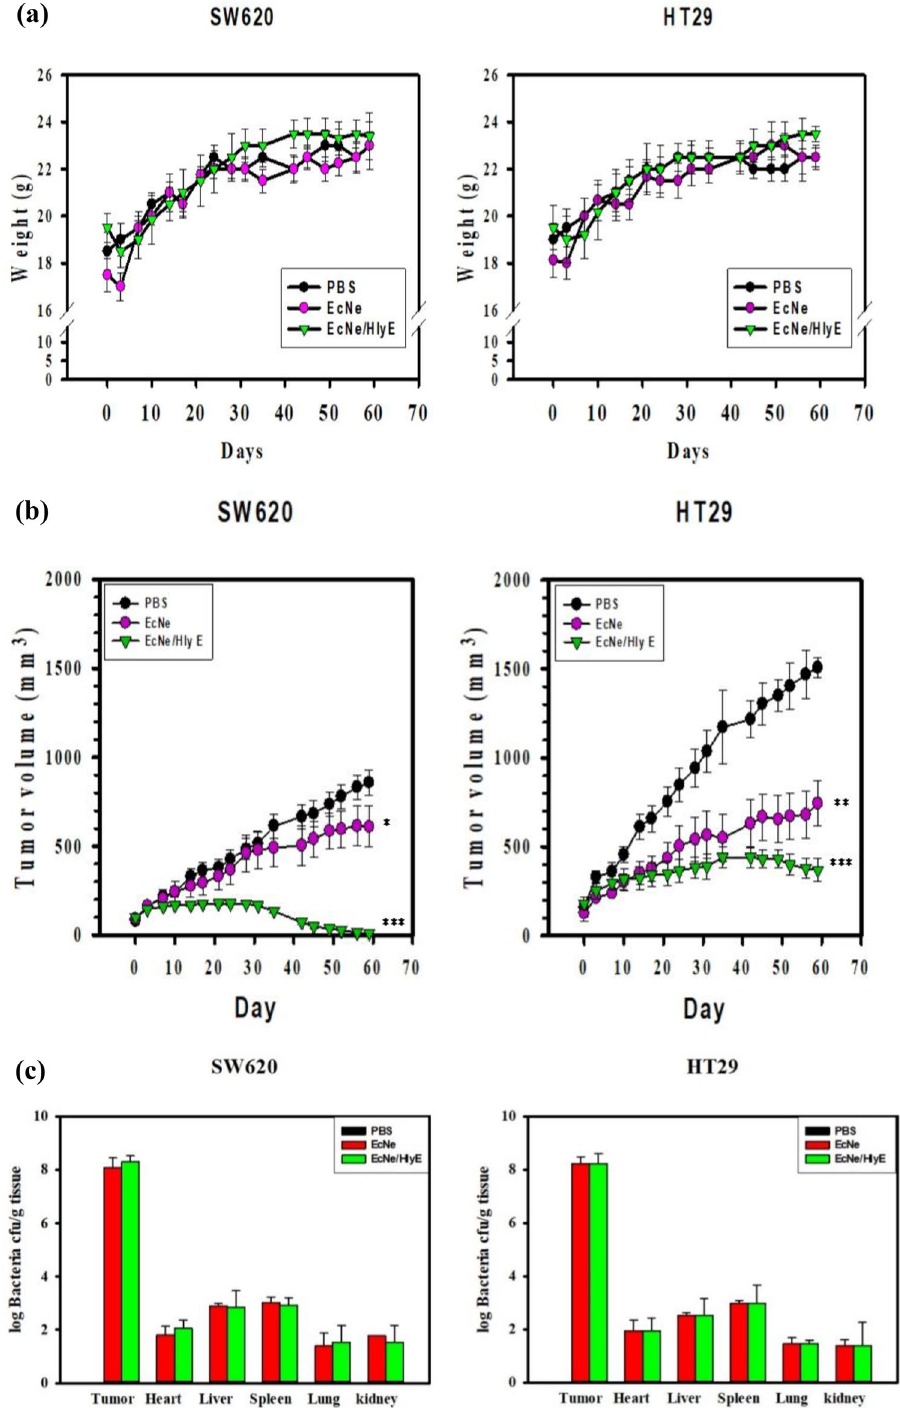
Figure 5. Tumor regression by EcNe/HlyE. ( a ) The change in the body weight of mice receiving intraperitoneal injection of bacteria. ( b ) Therapeutic effect of EcNe/HlyE on mice (n = 5) bearing SW620 or HT29 tumor cells. Tumor volumes (mm 3 ) were estimated using external calipers, and values were expressed as means ± standard deviations (SD). The statistical significance was analyzed by Student’s t-test (* p < 0.05; ** p < 0.01; and *** p < 0.001 vs. the PBS group). ( c ) Distribution of bacteria in